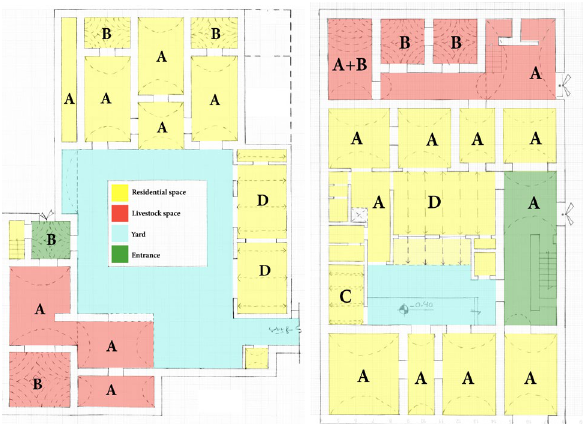
Figure 5. two examples of study houses, you can see the